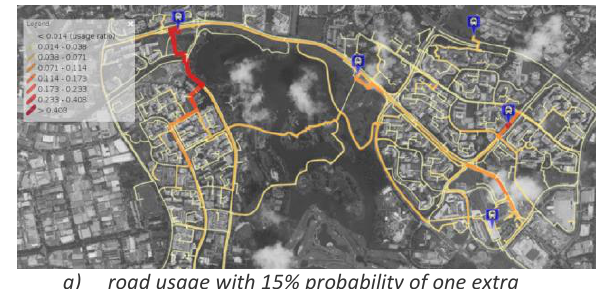
Figure 4: Conceptual Model for outdoor walkability model The third module, “The agent-based individual movement module”, considers the interaction of agent-environment, which can be determined using built environment data, such as physical obstacles and urban furniture. In addition, the QUEST outputs, including sky view factor, tree canopy shading, and building shading, are important parameters to be considered. Other QUEST model outputs, such as minimum and maximum temperature, thermal comfort index, and wind speed/direction are also important for this module. Figure 5 is a snapshot of the walkability model using temperature outputs of QUEST with different agent simulation settings.